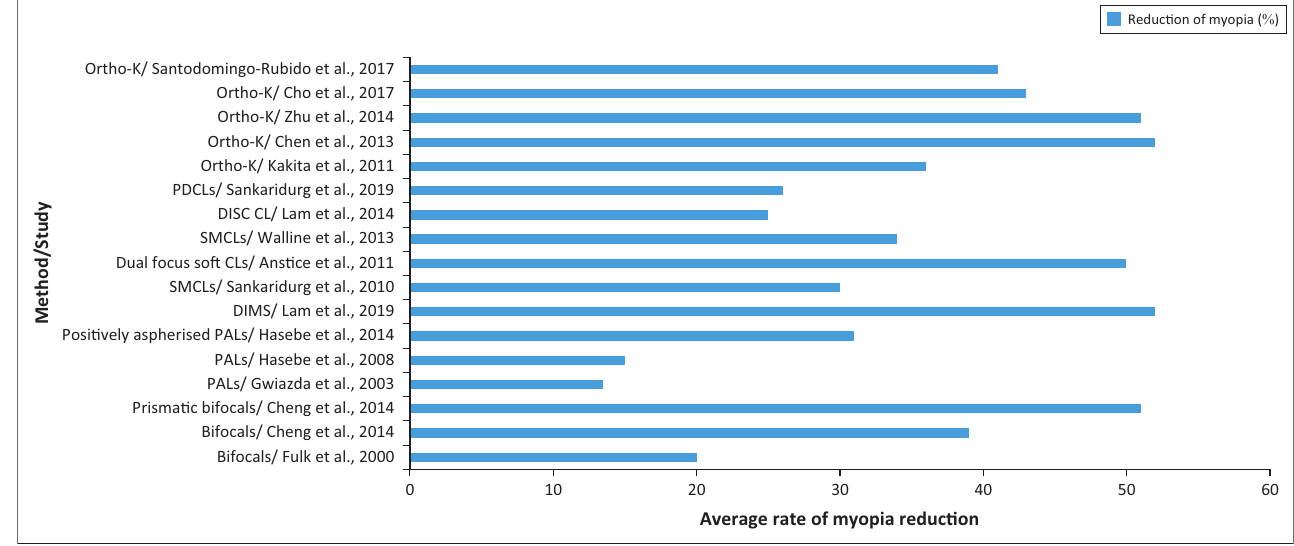
FIGURE 1: Bar chart showing the average reduction rates ( % ) of optical methods of myopia control. Under-correction was not included as the studies reviewed indicate an increase in myopic progression. Studies by Lam et al. (2019) (DIMS®) and Chen et al. (2013) (orthokeratology) indicate the best control (52 % ), while progressive addition lenses and bifocal lenses indicate the weakest (13 % and 20 % , respectively).